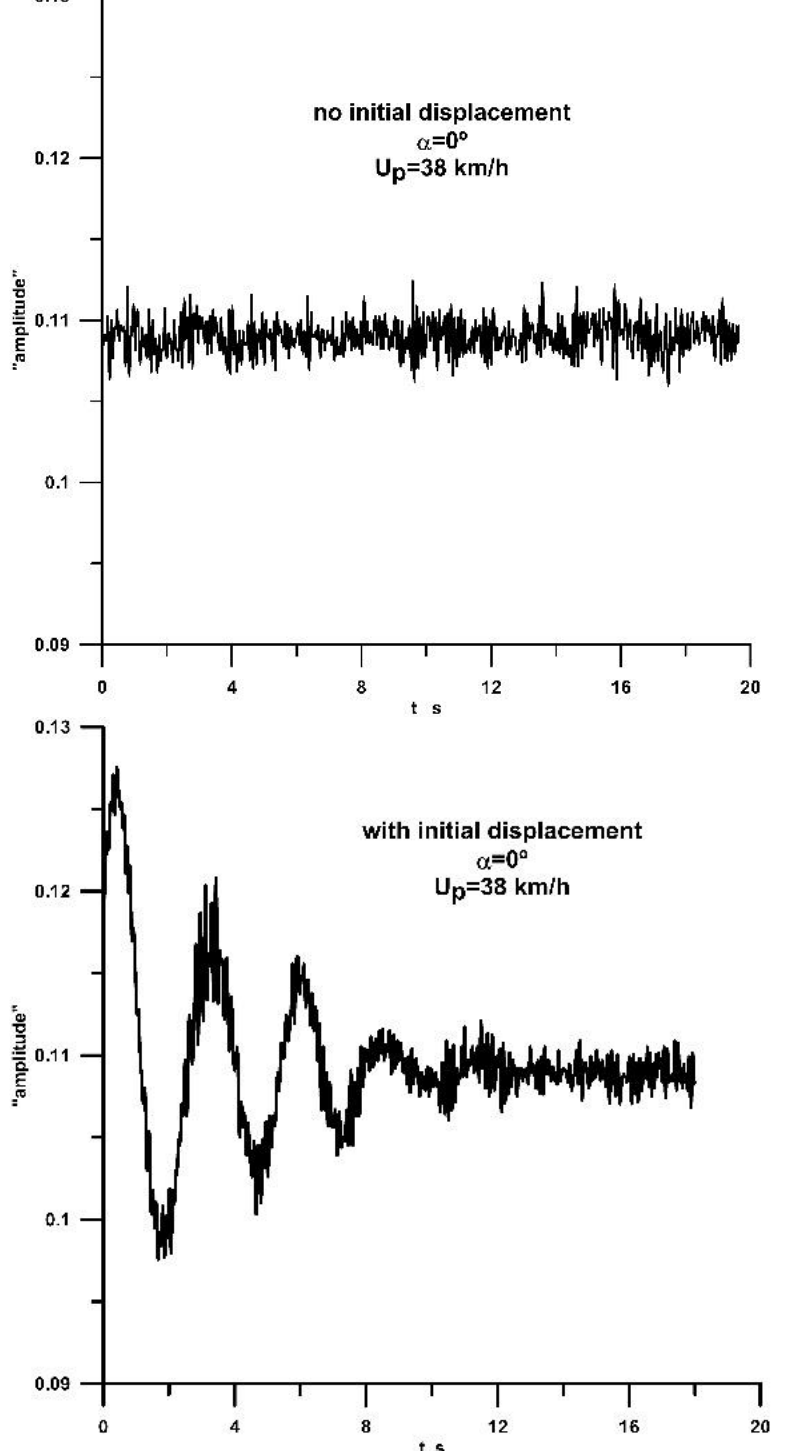
Figure 14. Deck torsional movement without and with previous swing